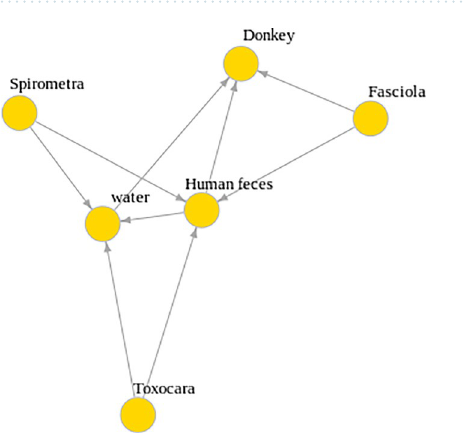
Figure 6. Schematic environmental interactions : Host-Parasite relationships depicted by